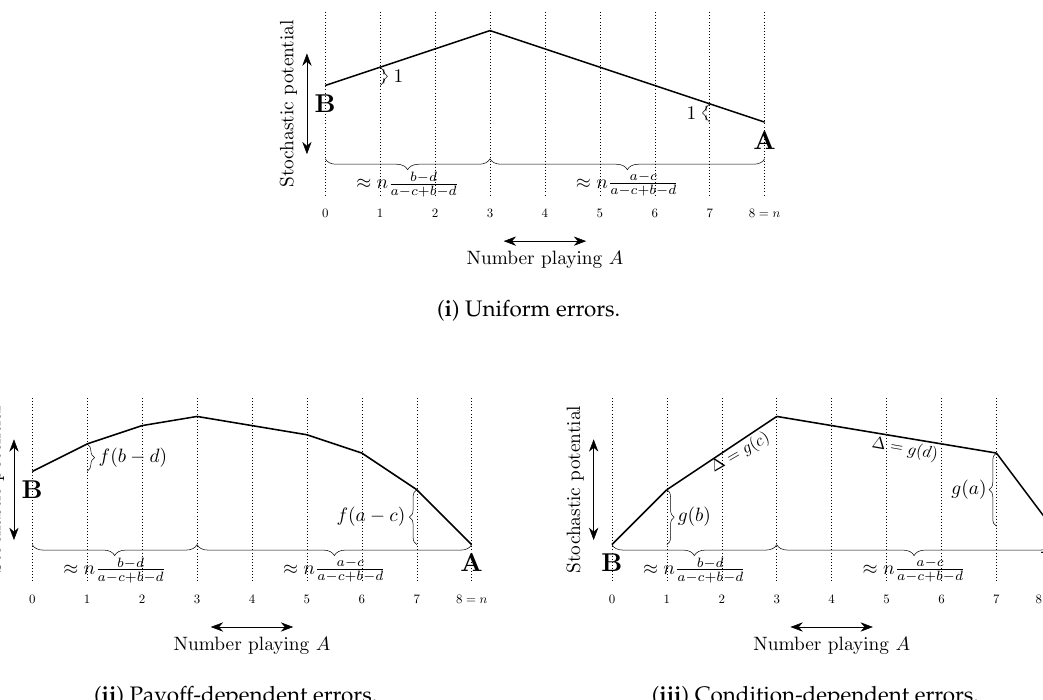
Figure 12. Stochastic potential under perturbed best response for coordination games under rematching every period. The game in Figure 10 is played by a population of size n = 8. Updating players maximize their expected payoff over all possible opponents and the threshold between basins of attraction is approximated by n b − d as population size n becomes large. In Panel ( i ), as all errors a c + b d − − have equal steepness, the convention with the longer basin of attraction, the risk dominant convention, is stochastically stable. In Panel ( ii ), the path exiting the risk dominant convention is not only longer, but also steeper, so it remains stochastically stable. In Panel ( iii ), for large enough populations, we can ignore the g ( a ) and g ( b ) terms, so that stochastic stability is determined by comparing g ( c ) b − d and g ( d ) a − c . In this example, the difference in steepnesses g ( c ) and g ( d ) is large enough that a c + b d − − steepness dominates length and the maximin convention is stochastically